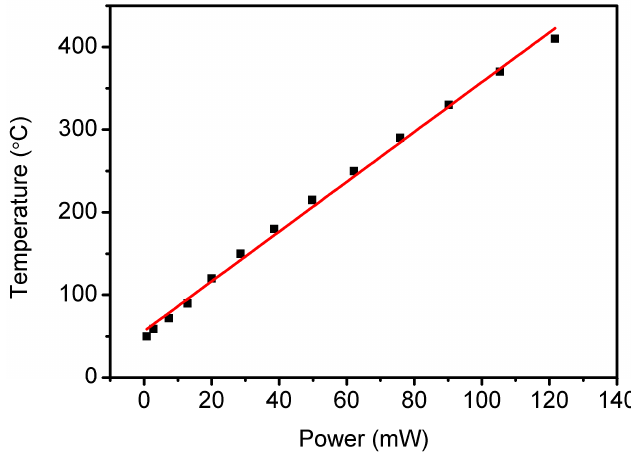
Figure 3. Power consumption versus measured maximum metal oxide film temperature.